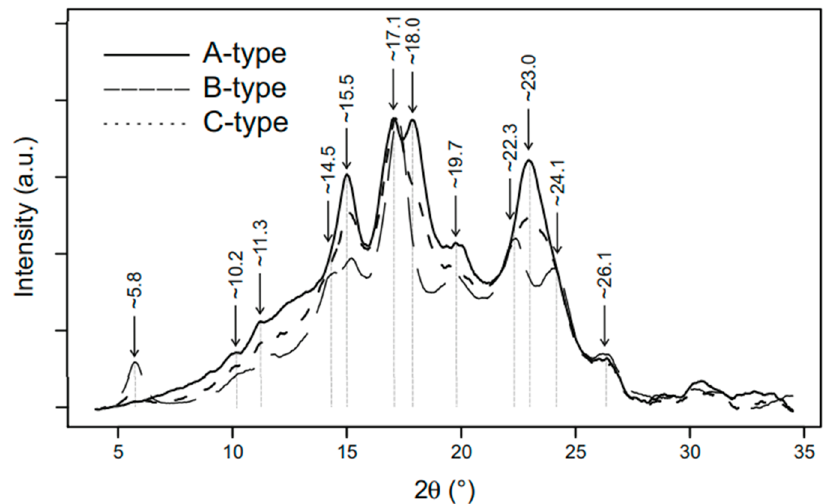
Figure 5. The type of starch crystallinity (type A, type B, and type C) as shown by X-ray diffraction patterns [105], with permission from Springer Nature, 2018.